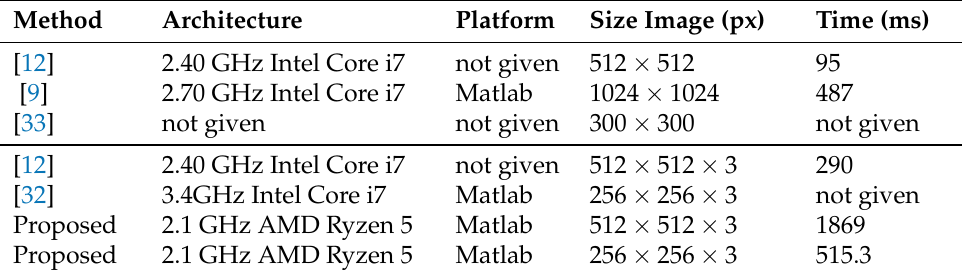
Table 4. Encryption computation time